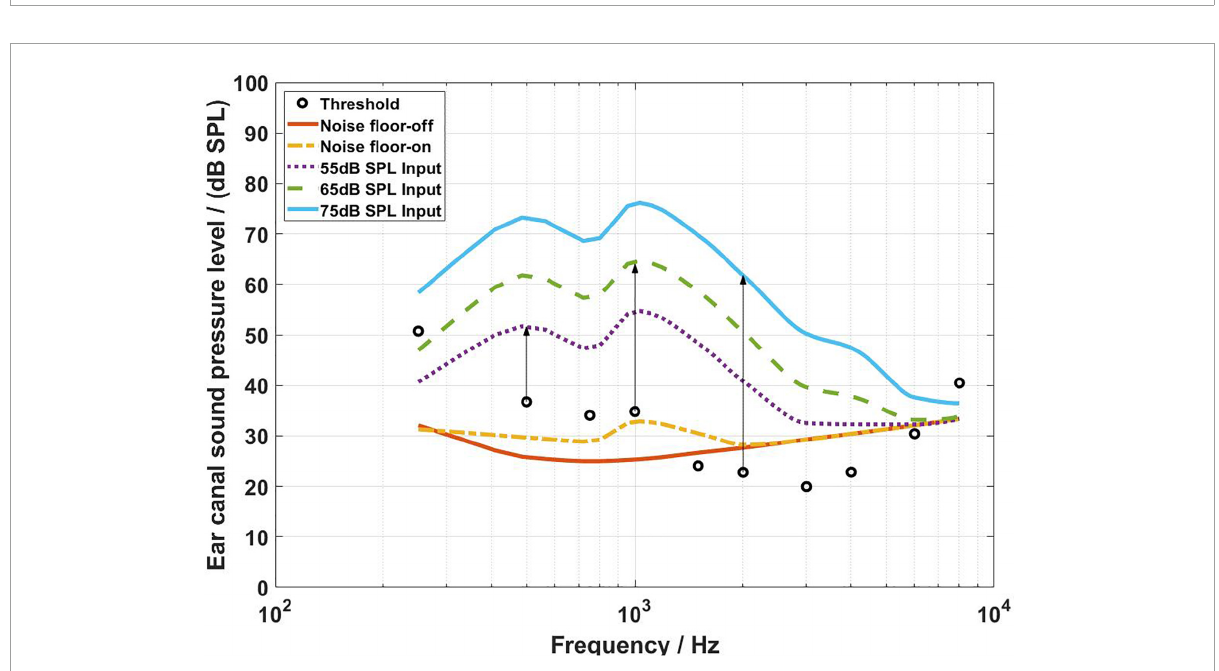
FIGURE5 The sound pressure level (SPL) corresponding to the bone conduction (BC) hearing threshold (referenced to the ear canal SPL) and the aided responses at 55, 65, and 75 dB SPL input levels. The arrows depict the audibility